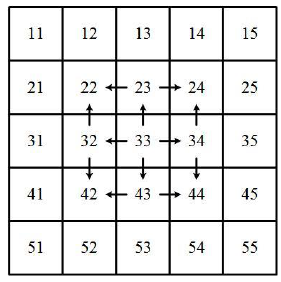
Figure 3. Weighted adjustment sequence.